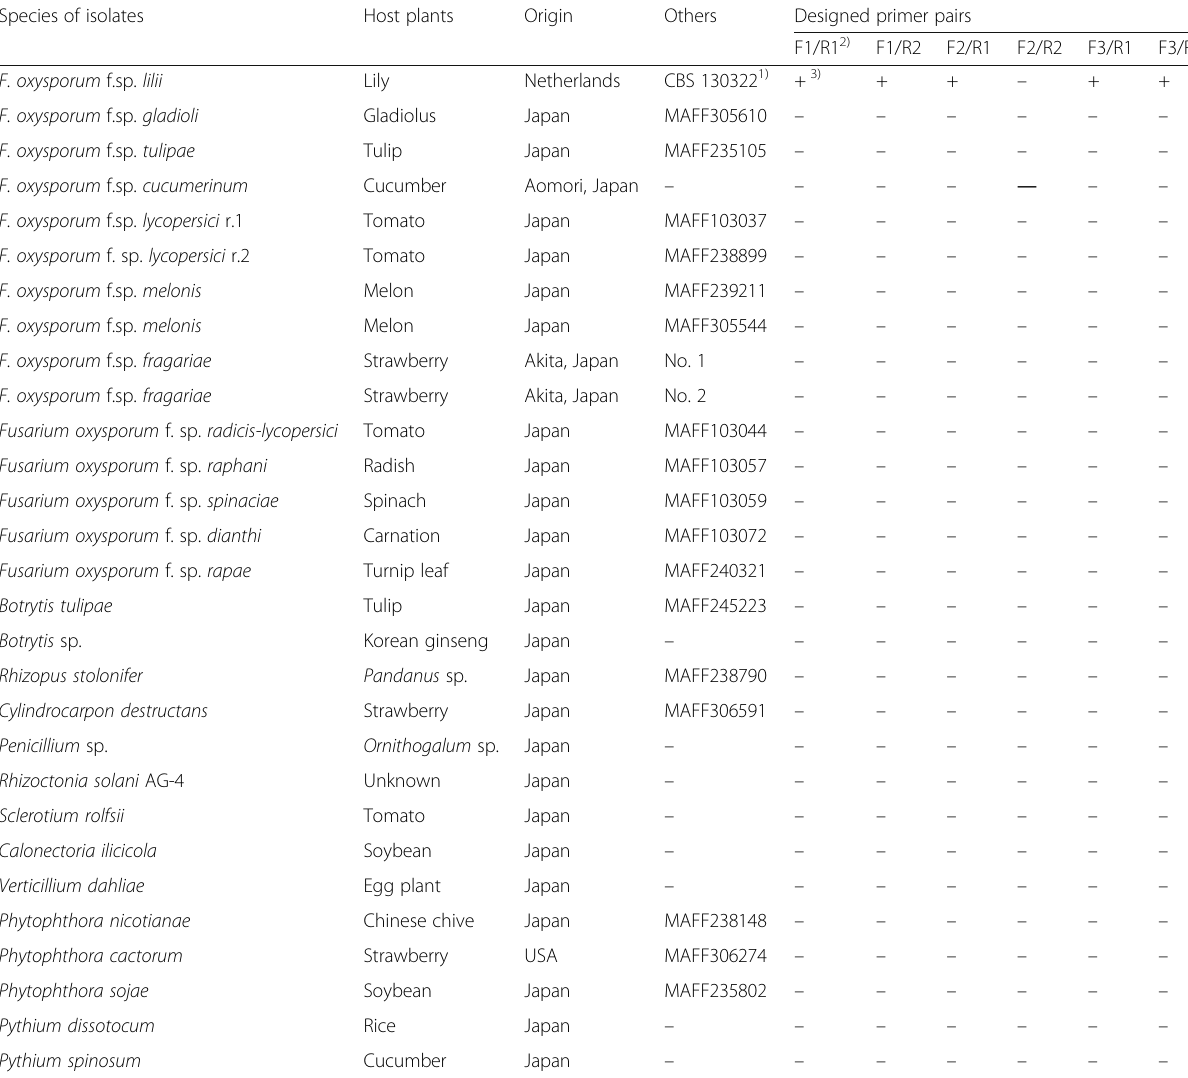
Table 2 Isolates of Fusarium oxysporum , soilborne fungi, and oomycetes used in this study and amplifications by different